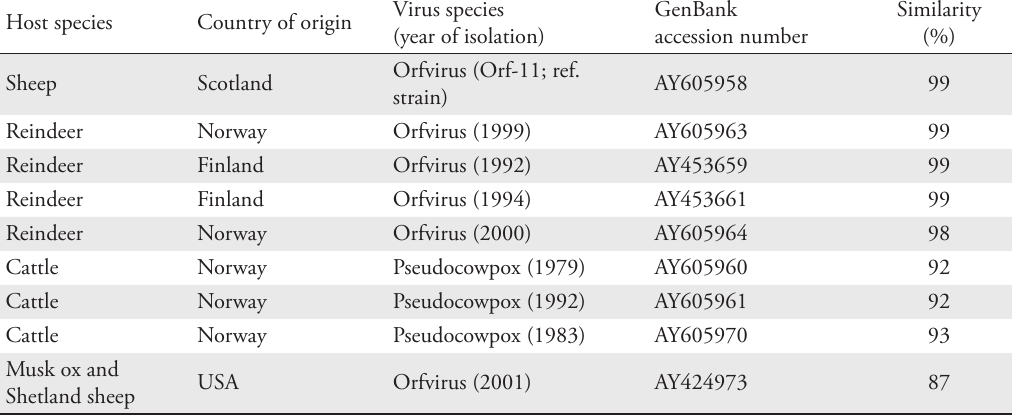
Table 3. Genetic similarity between the DNA sequence obtained from the PCR product (376 base pairs; B2L-gene) from a liver sample from a reindeer ( Rangifer tarandus tarandus ; animal 4) and corresponding DNA sequences from other parapoxvirus isolates